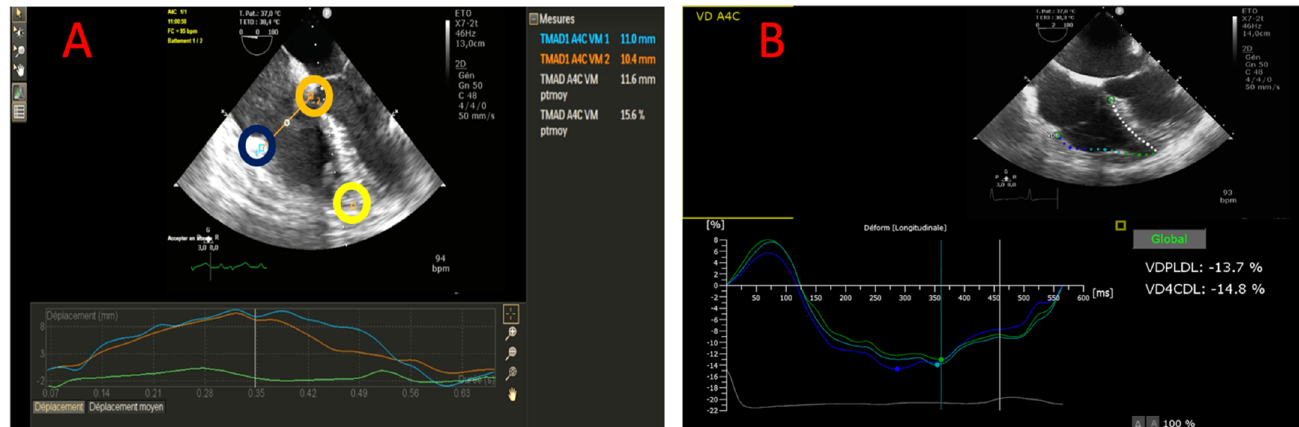
Figure 1. Measurement of 2D-STE parameters in a mid-esophageal four-chamber view. ( A ) TAD. A lateral point (blue circle) and a septal point (orange circle) were placed at the bottom of the RV free wall and the bottom of the interventricular septum. A third point was placed at the apex (yellow circle). TAD lateral, TAD septal and RV-LSF (%) value were automatically displayed. The mid-annular point is automated selected by the software. ( B ) region of interest was generated automatically and adjusted manually. RV-FWLS and RV-GLS were calculated automatically by the software.